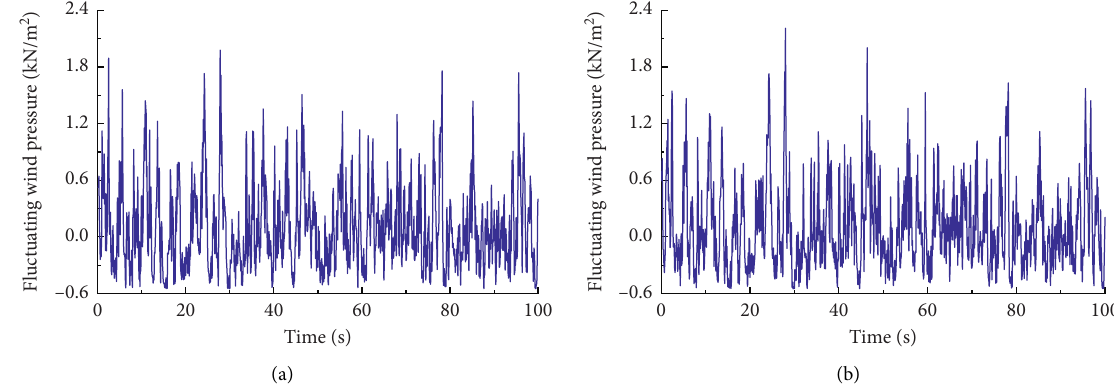
Figure 9: Fluctuating wind pressure time-history curve in different space nodes. (a) Node 4. (b) Node 10.